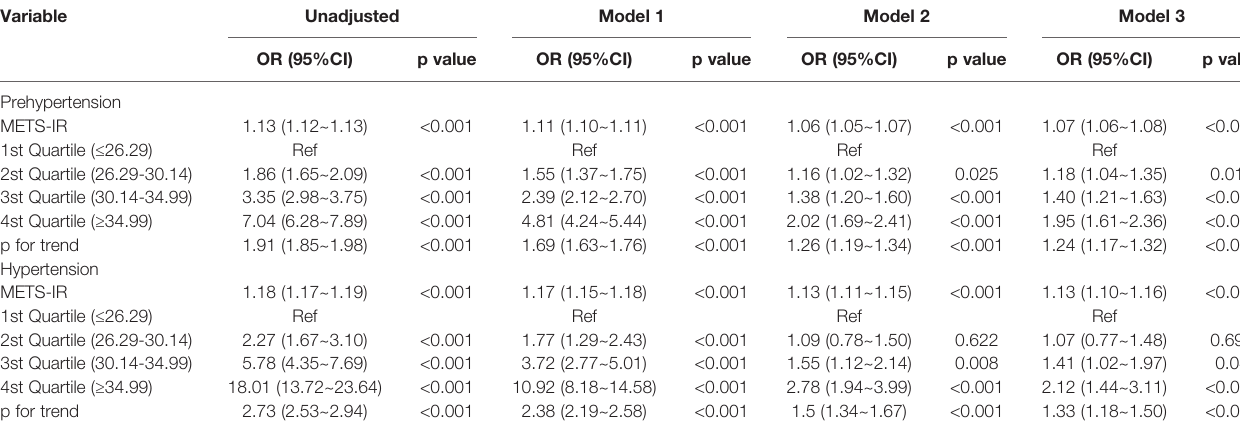
TABLE 3 | Multivariable-adjust ORs and 95%CI of the METS-IR index quartiles associated with prehypertension and hypertension.